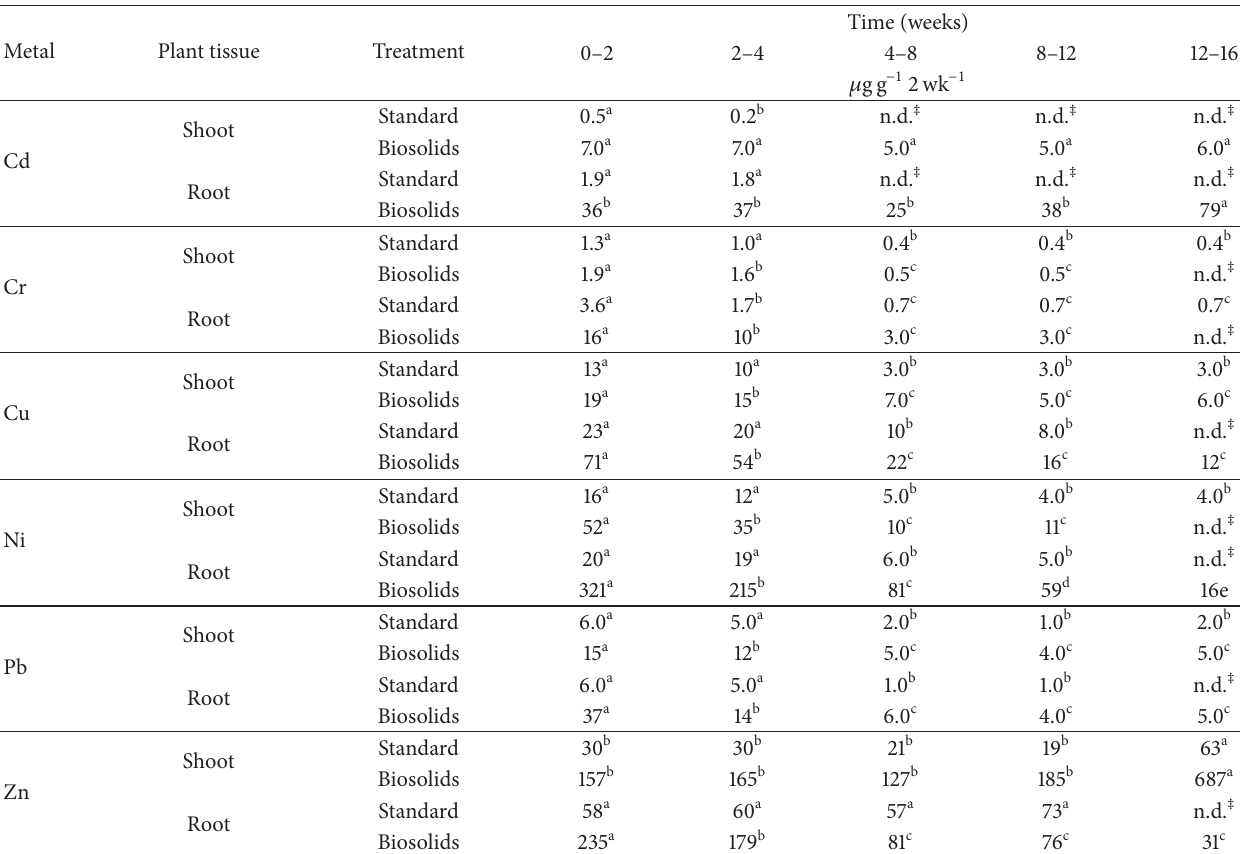
Table 2: Metal uptake rates (means where 𝑛 = 4 ) by corn grown on sand media amended, without biosolids (Standard) and with biosolids at different growth stages †